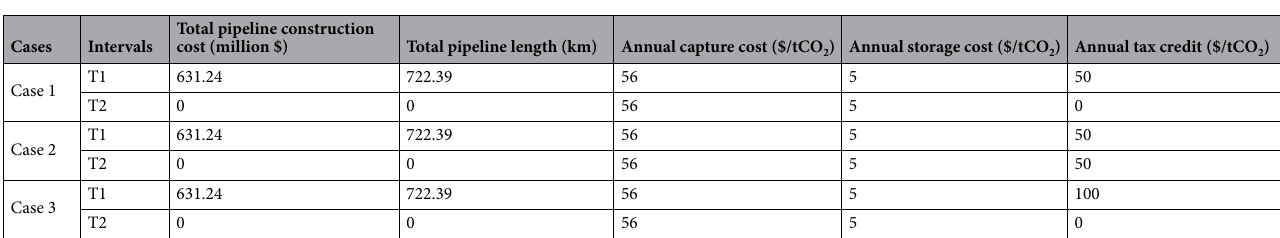
Table 4. Summary of the final optimization solutions for Cases